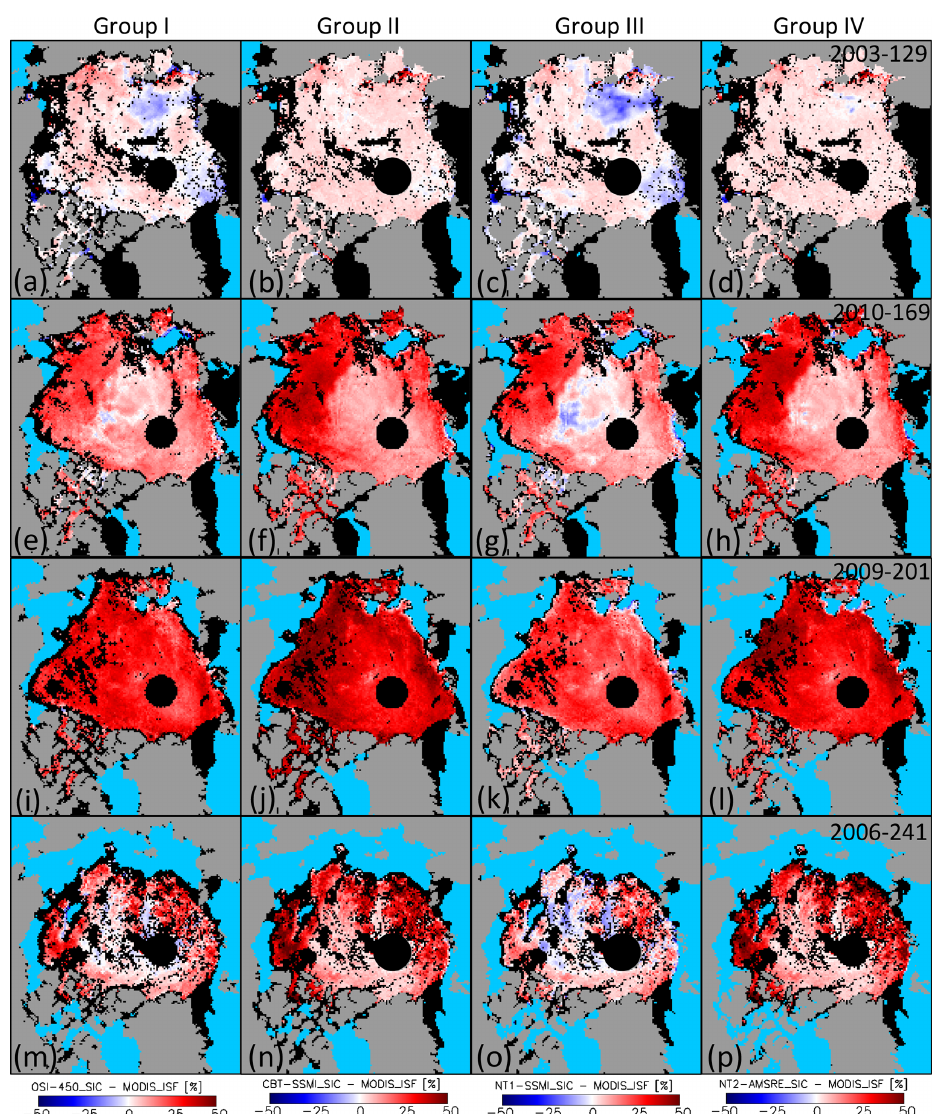
Figure 7. Maps of the difference PMW sea-ice concentration minus MODIS ice surface fraction (ISF) for the same 8d periods as shown in Fig. 4. The leftmost column shows OSI-450, representing group I; the second column CBT-SSMI, representing group II; the third column NT1-SSMI, representing group III; and the rightmost column NT2-AMSR-E, representing group IV. Black areas denote invalid or missing data, clouds, or grid cells being ice-covered but not considered further in the analysis, e.g. in the Greenland Sea or Hudson Bay. The row starting with (a) is representative of pre-melt, the row starting with (e) is melt advance, the row starting with (i) is at the peak of melt, and the row starting with (m) is at the end of the